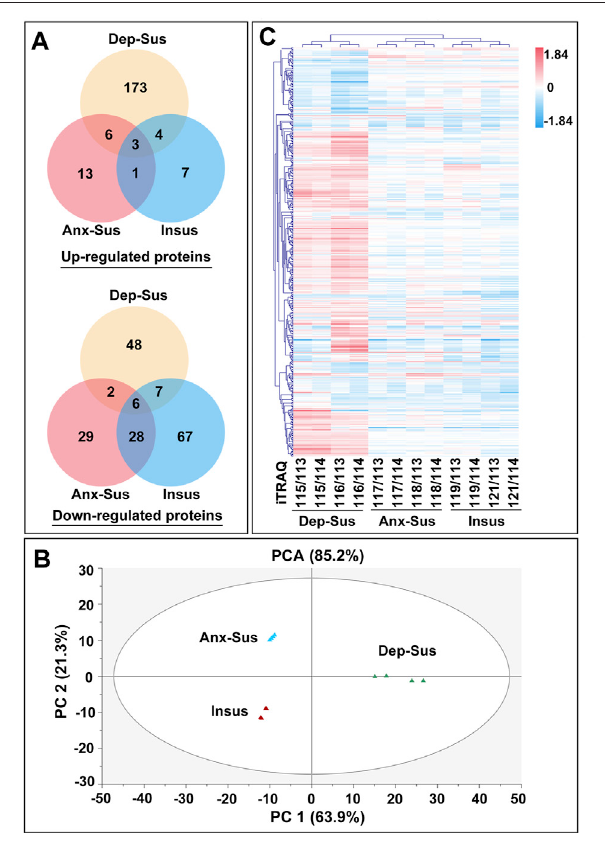
FIGURE 2 | Expression analysis of the abnormally expressed proteins identi fi ed in the depression-susceptible (Dep-Sus), anxiety-susceptible (Anx- Sus), and insusceptible (Insus) groups. (A) Venn diagrams displaying the number of abnormally expressed proteins. (B) PCA of the abnormally expressed proteins based on their fold changes in the three stressed groups relative to the control (Ctrl) group. (C) Hierarchical clustering of the abnormally abundantproteinsrepresentinglog2oftheirfoldchangesinthethreestressed groups in relative to the Ctrl group. Red represents upregulation, and blue represents downregulation with darker shades indicating greater changes in expression. The eight isobaric tags used are shown.